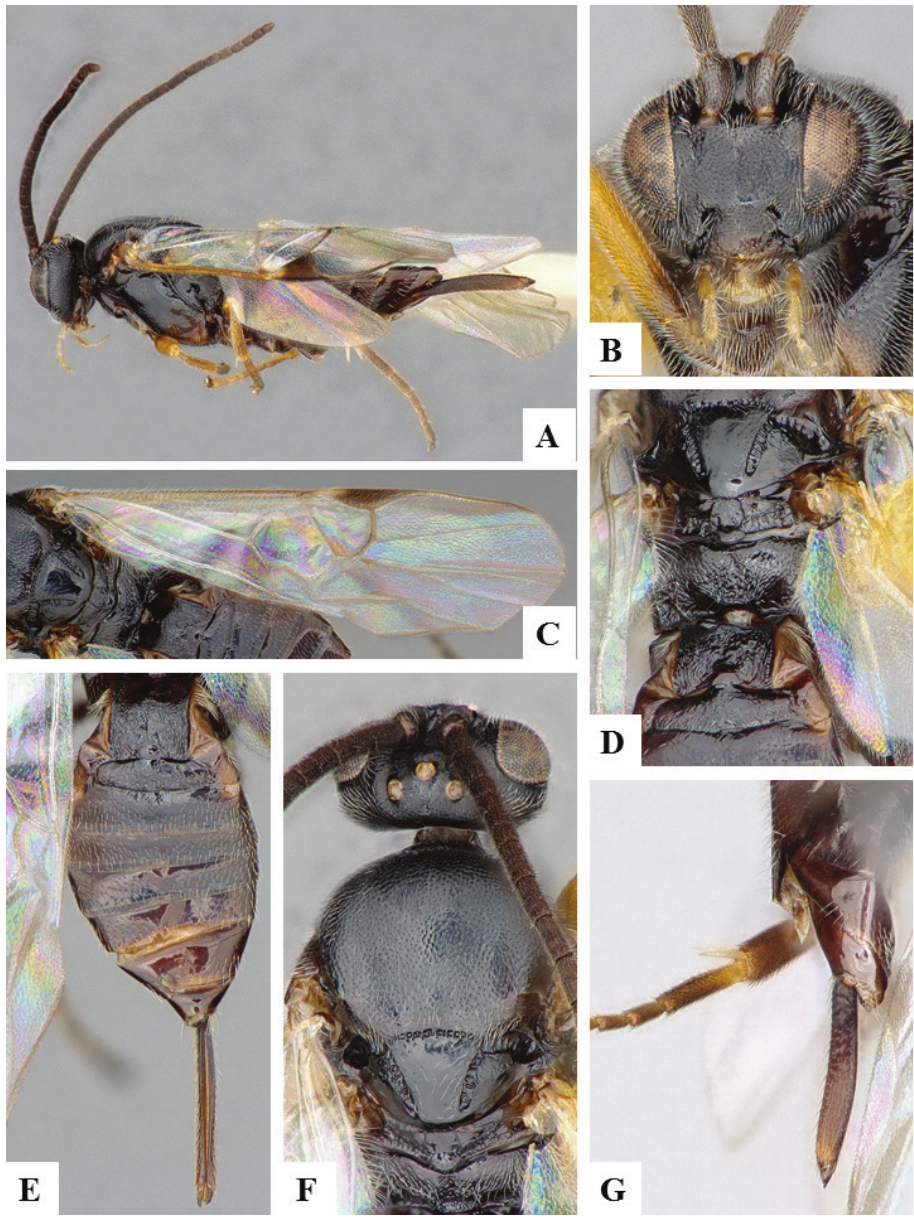
Figure 20. Dolichogenidea cacoeciae. A Habitus, lateral B Head, frontal C Wings D Mesosoma and metasoma (partially), dorsal E Metasoma, dorsal F Head and mesosoma, dorsal G Ovipositor